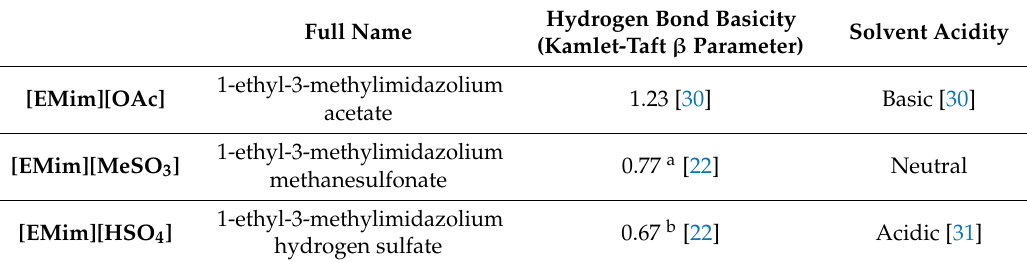
Table 1. Ionic liquids used in this study based and select solvent